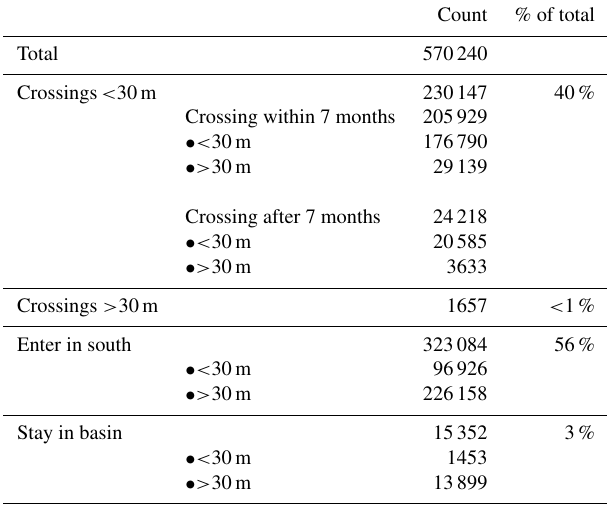
Table 1. Number of trajectories with different